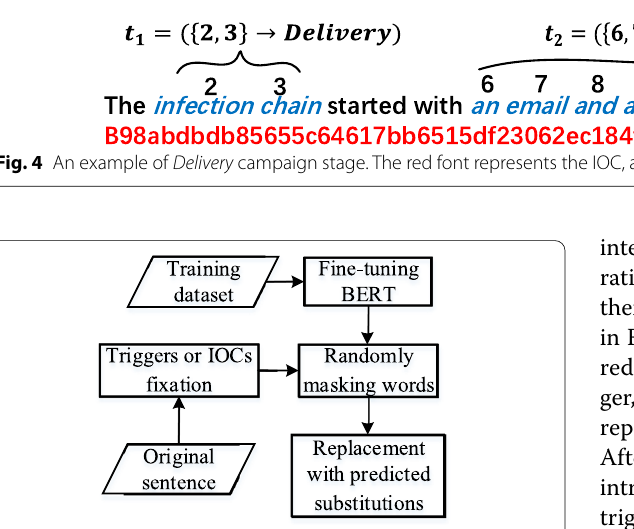
Fig. 5 Data augmentation